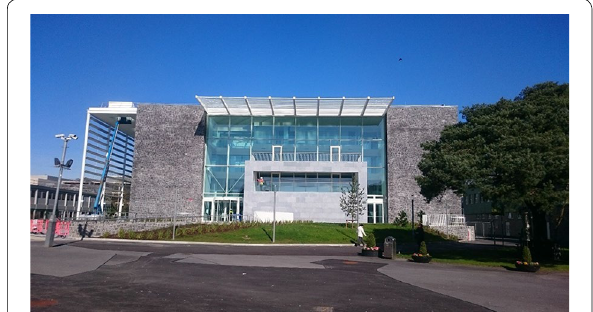
Fig. 2 Human biology building.